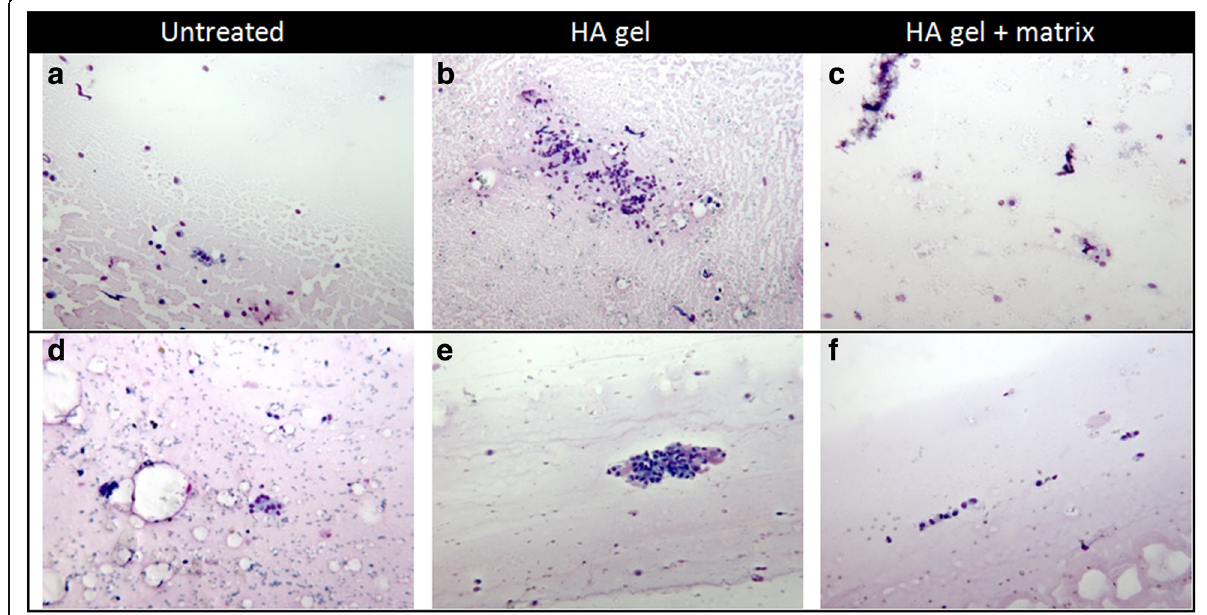
Fig. 5 Histopathological evaluation of the synovial fluid smear. a – c shows the animal no. 105, 110 and 116 after 4 weeks of treatment and d – f shows the animal no. 102, 109 and 115 after 12 weeks of treatment as representative